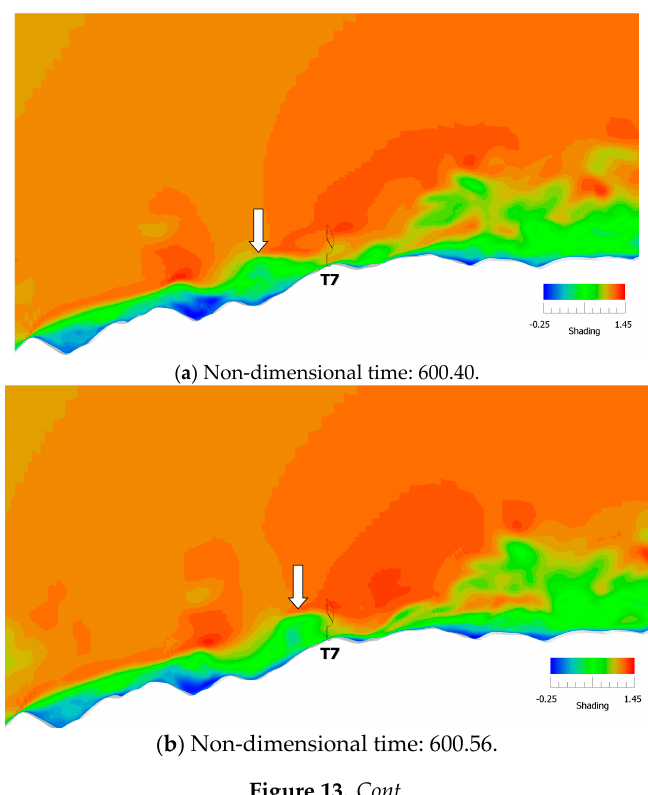
( b ) Non-dimensional time: 600.56.